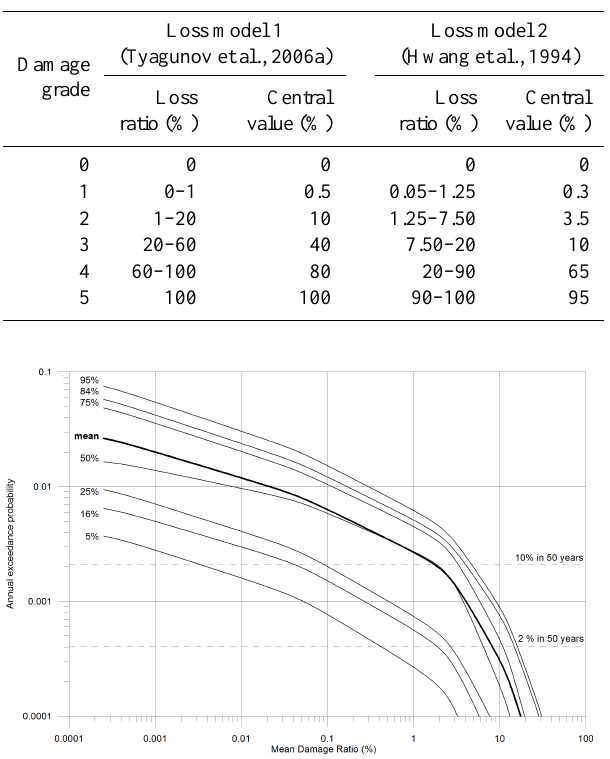
Table 1. The loss models employed in this study.